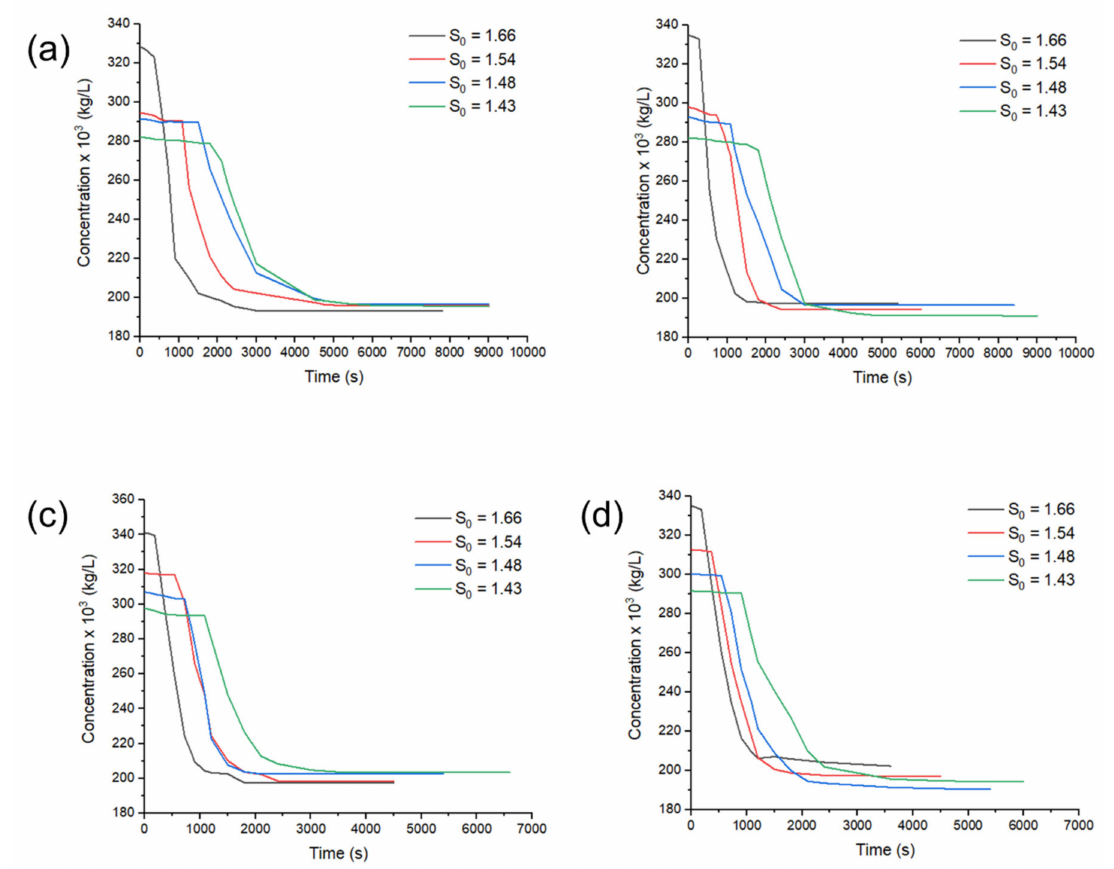
Figure 4. Representative desupersaturation curves of co-crystallization of 2:1 HBz–NaBz co-crystals at different S 0 values of 1.66, 1.54, 1.48, and 1.43 ( a ) without templating molecules addition, ( b ) with dissolved NaBz templating molecules addition, ( c ) with dissolved 2:1 HBz–NaBz co-crystal templating molecules addition, ( d ) with dissolved 1:1 HBz–NaBz co-crystal templating molecules